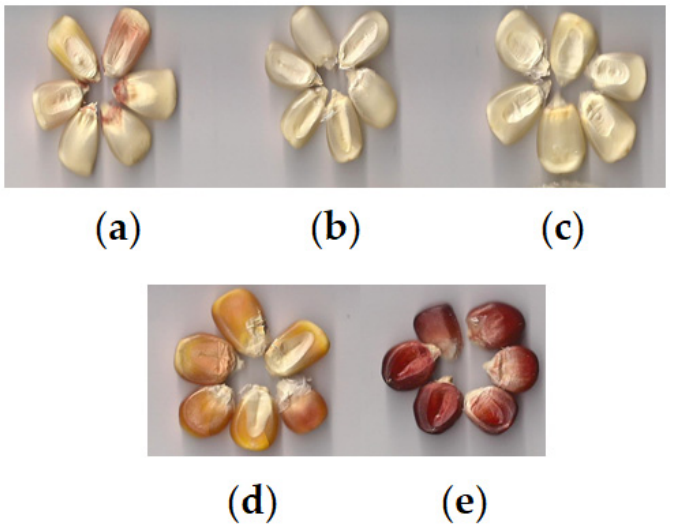
Figure 1. Accessions of native maize from the Jalisco Highlands, Mexico: ( a ) 202; ( b ) 203; ( c ) 204; ( d ) 205; ( e ) 206.